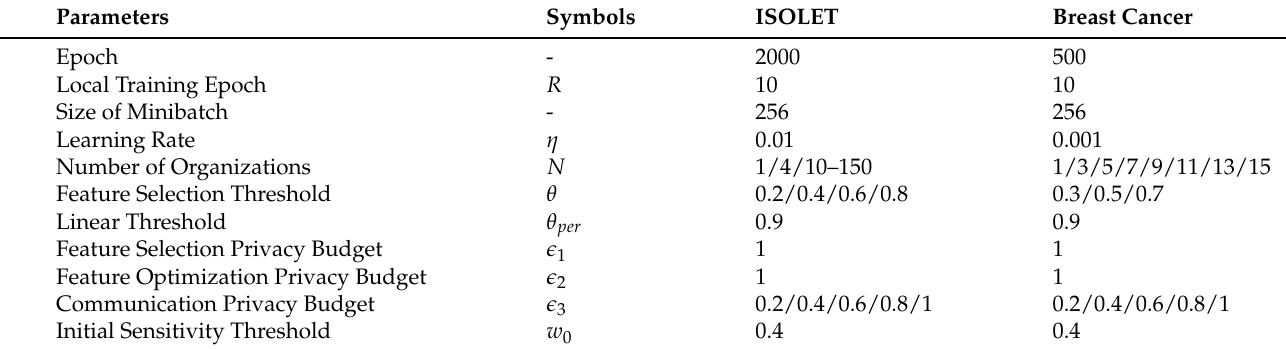
Table 1. Experimental